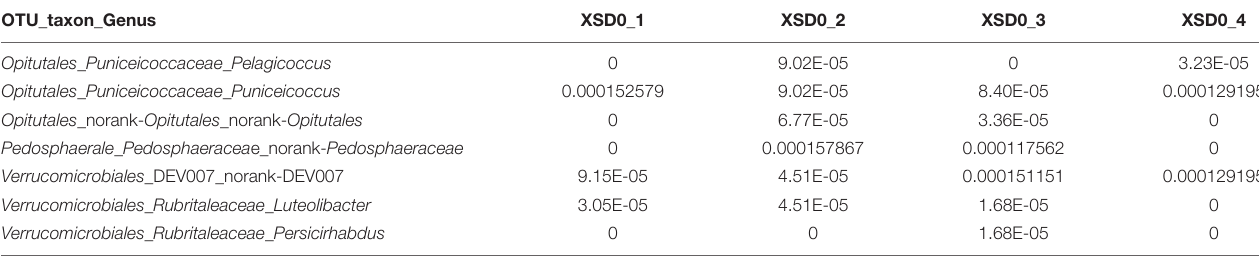
TABLE 1 | The relative proportion of Verrucomicrobia